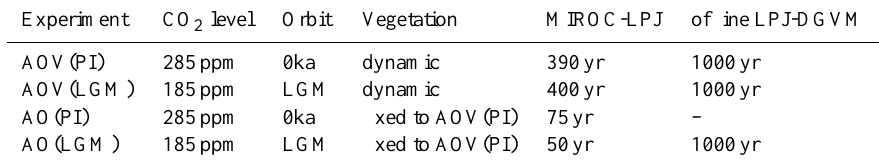
Table 1. Settings of the experiments performed in this study.